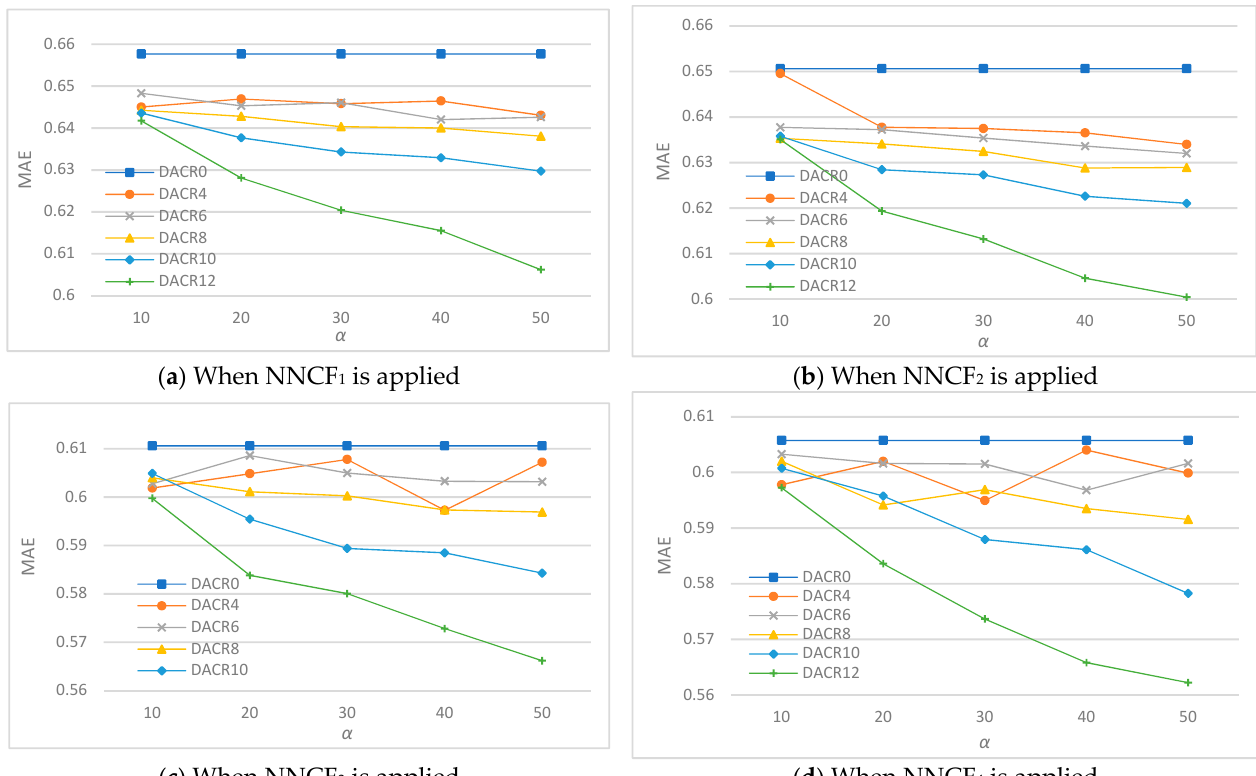
Figure 7. The performance of the proposed recommender under different DACR + NNCF settings. Table 8. The average MAE improvement compared to no CS item rating added.